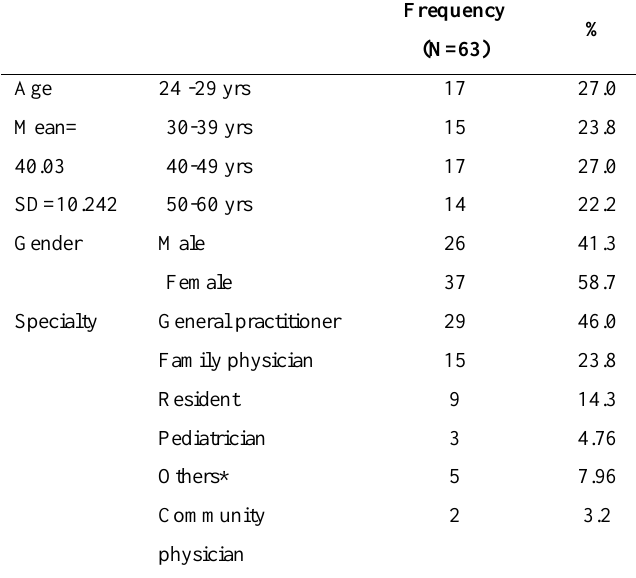
Table 2: Distribution of PHC doctors according to age, gender, & specialty.